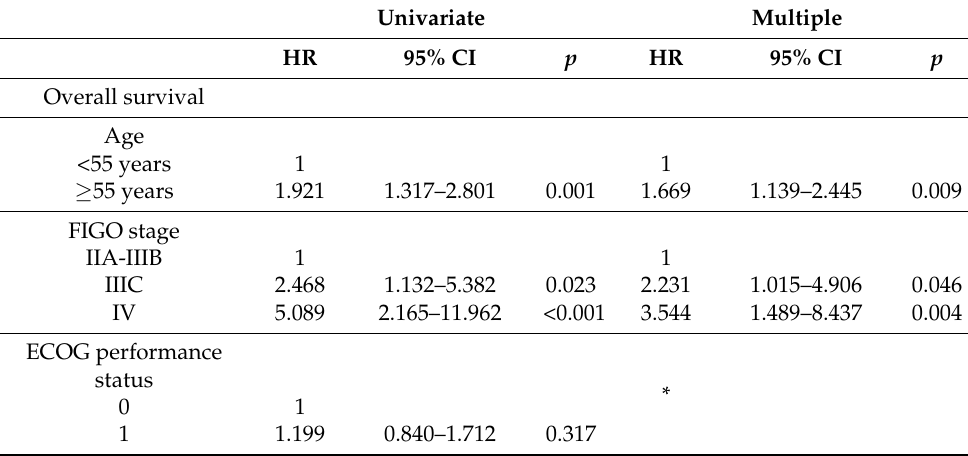
Table 4. Cox’s proportional hazard regression for overall and progression-free survival. CI, confi- dence interval; HR, hazard ratio adjusted for histological type (HGSOC high grade serous ovarian cancer vs. LGSOC low grade serous ovarian cancer and other types); * not included in the final multiple regression